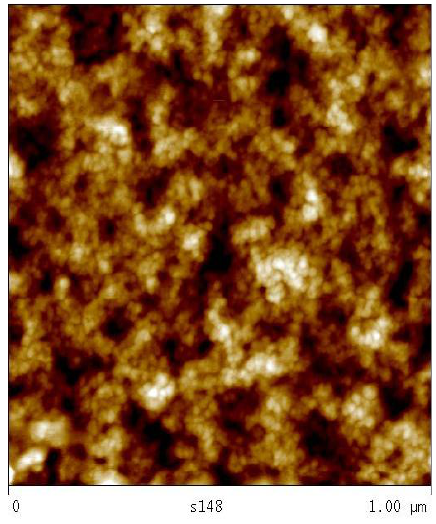
Figure 2. Solution (S 22) of polymer C2 2 wt % in aqueous ammonia (1%): AFM image. Film formation and